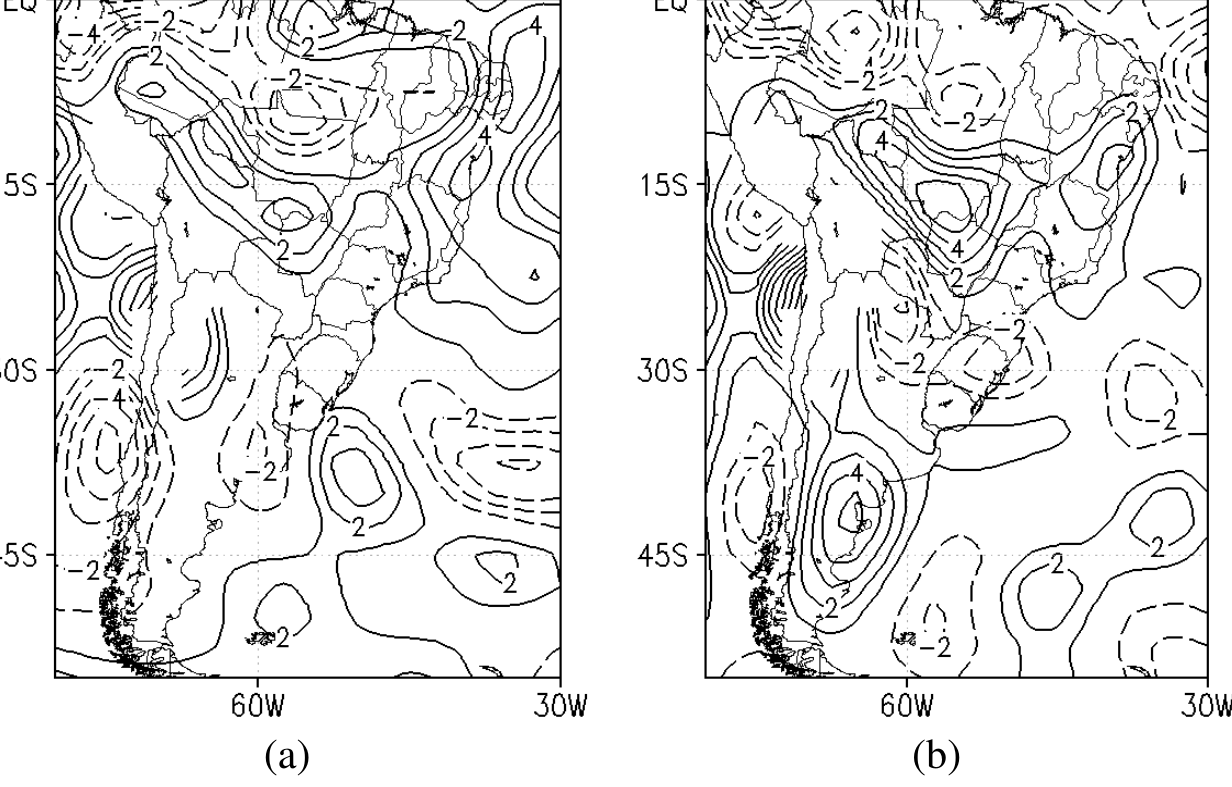
Fig. 15. Episode-mean fields of adiabatic heating due to vertical motions (K day − 1 ) at 700hPa. (a) Case 29, and (b) Case Fig. 15 – Episode-mean fields of adiabatic heating due to vertical motions (K dia -1 ) at 700 hPa: (a) Case 29, and (b) case 32.